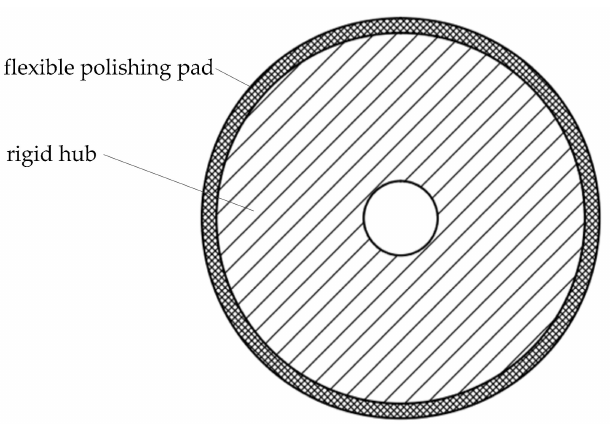
Figure 2. Structure of the polishing